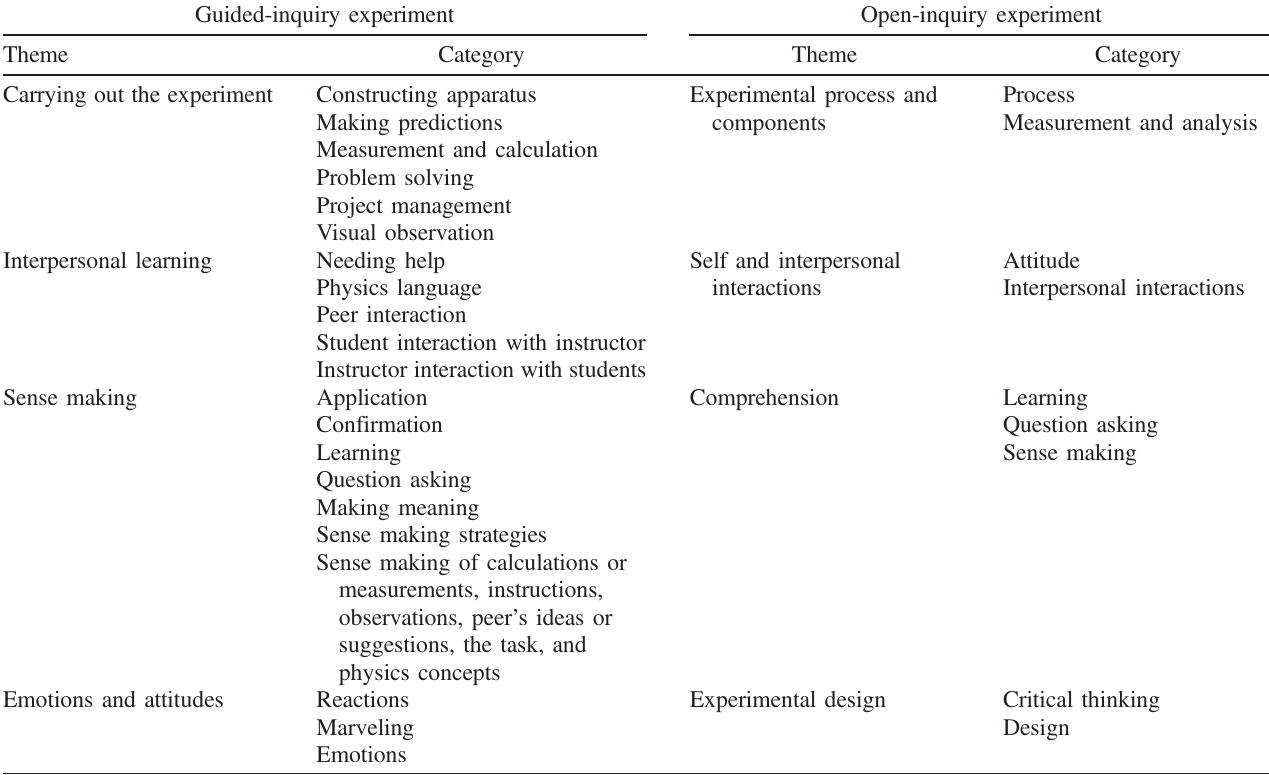
TABLE II. Themes and categories that emerged from qualitative coding analysis of the guided-inquiry data set and the open-inquiry data